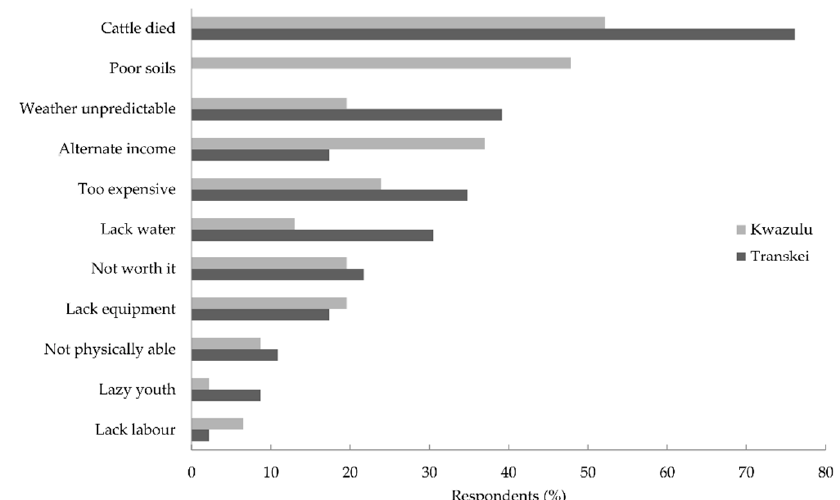
Figure 4. Reasons given by past farmers for exiting their own crop farming activities in KwaZulu ( n = 42) and Transkei ( n = 48). Cumulative respondent percentages total more than 100% as more than one answer could be provided.